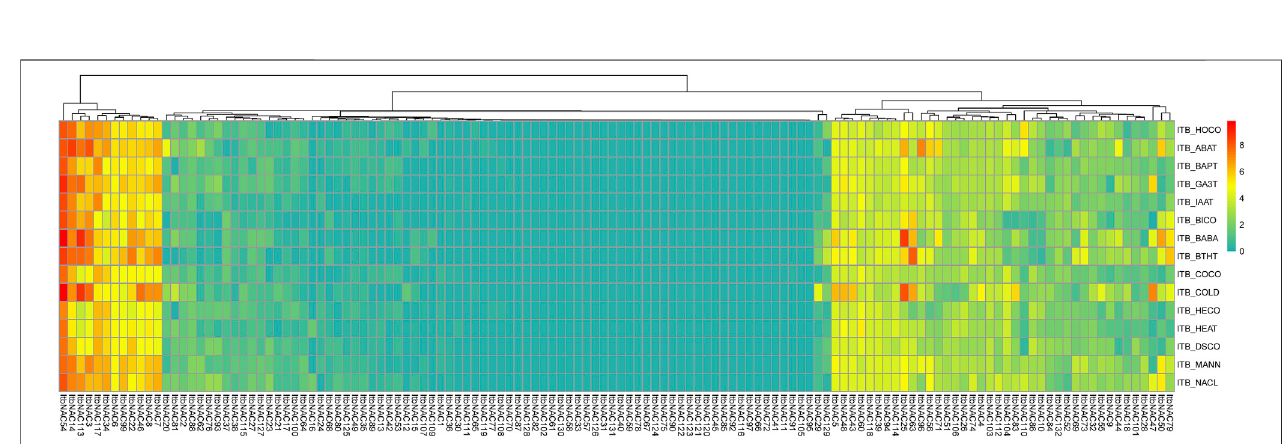
FIGURE 9 | Expression pro fi les ofItbNAC genes under various stresses in wild sweet potato Ipomoea triloba. The transcript abundance was examined using RNA-Seq gene expressiondata.Theexpressionpro fi leswerecalculatedviaaheatmapfromthelog2(FPKM+1)value,andshownasablue-yellow-redgradientbyusingtheheatmappackageinR version3.4.0.HOCO,hormonecontrol;ABAT,ABAtreatment;BAPT,BAtreatment;GA 3 T,GA 3 treatment;IAAT,IAAtreatment;BICO,bioticstresscontrol;BABA,beta-aminobutyric acid treatment; BTHT, benzothiadiazole S-methylester treatment; COCO cold control; HECO, heat control; DSCO, drought and salt control; MANN, mannitol drought